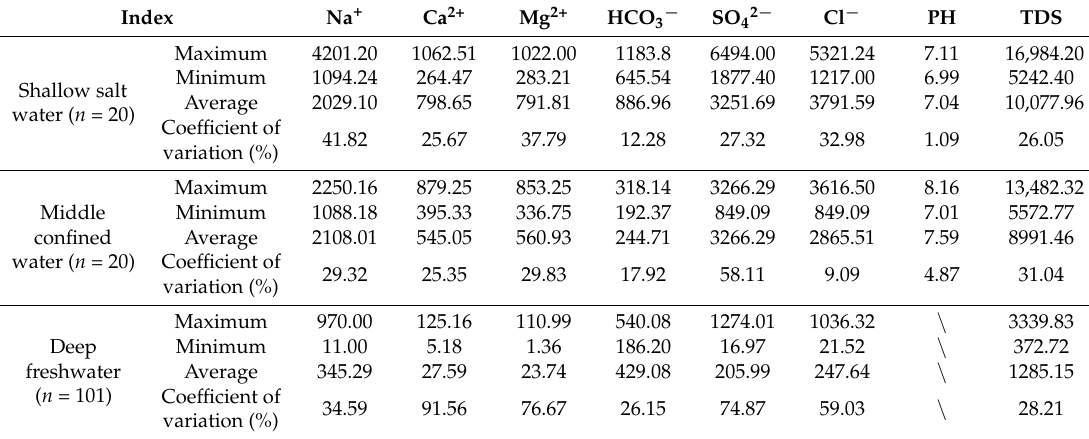
Table 3. Characteristic values of conventional hydrochemical composition of groundwater ( n = 141).